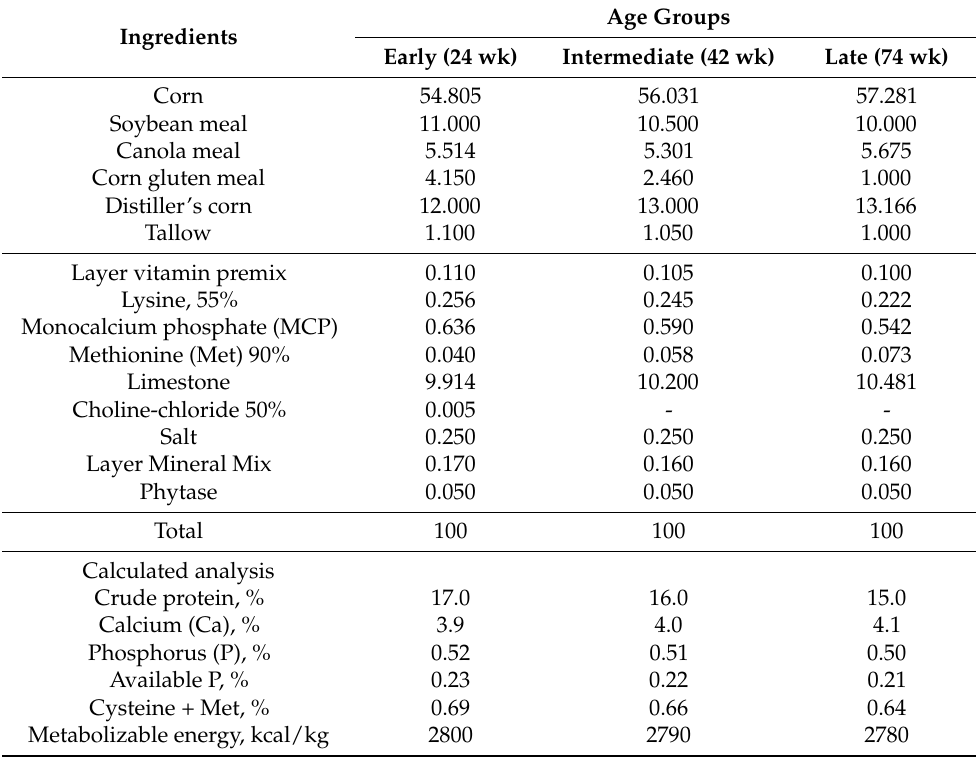
Table 1. The composition (%, w / w ) and calculated analysis of the basal